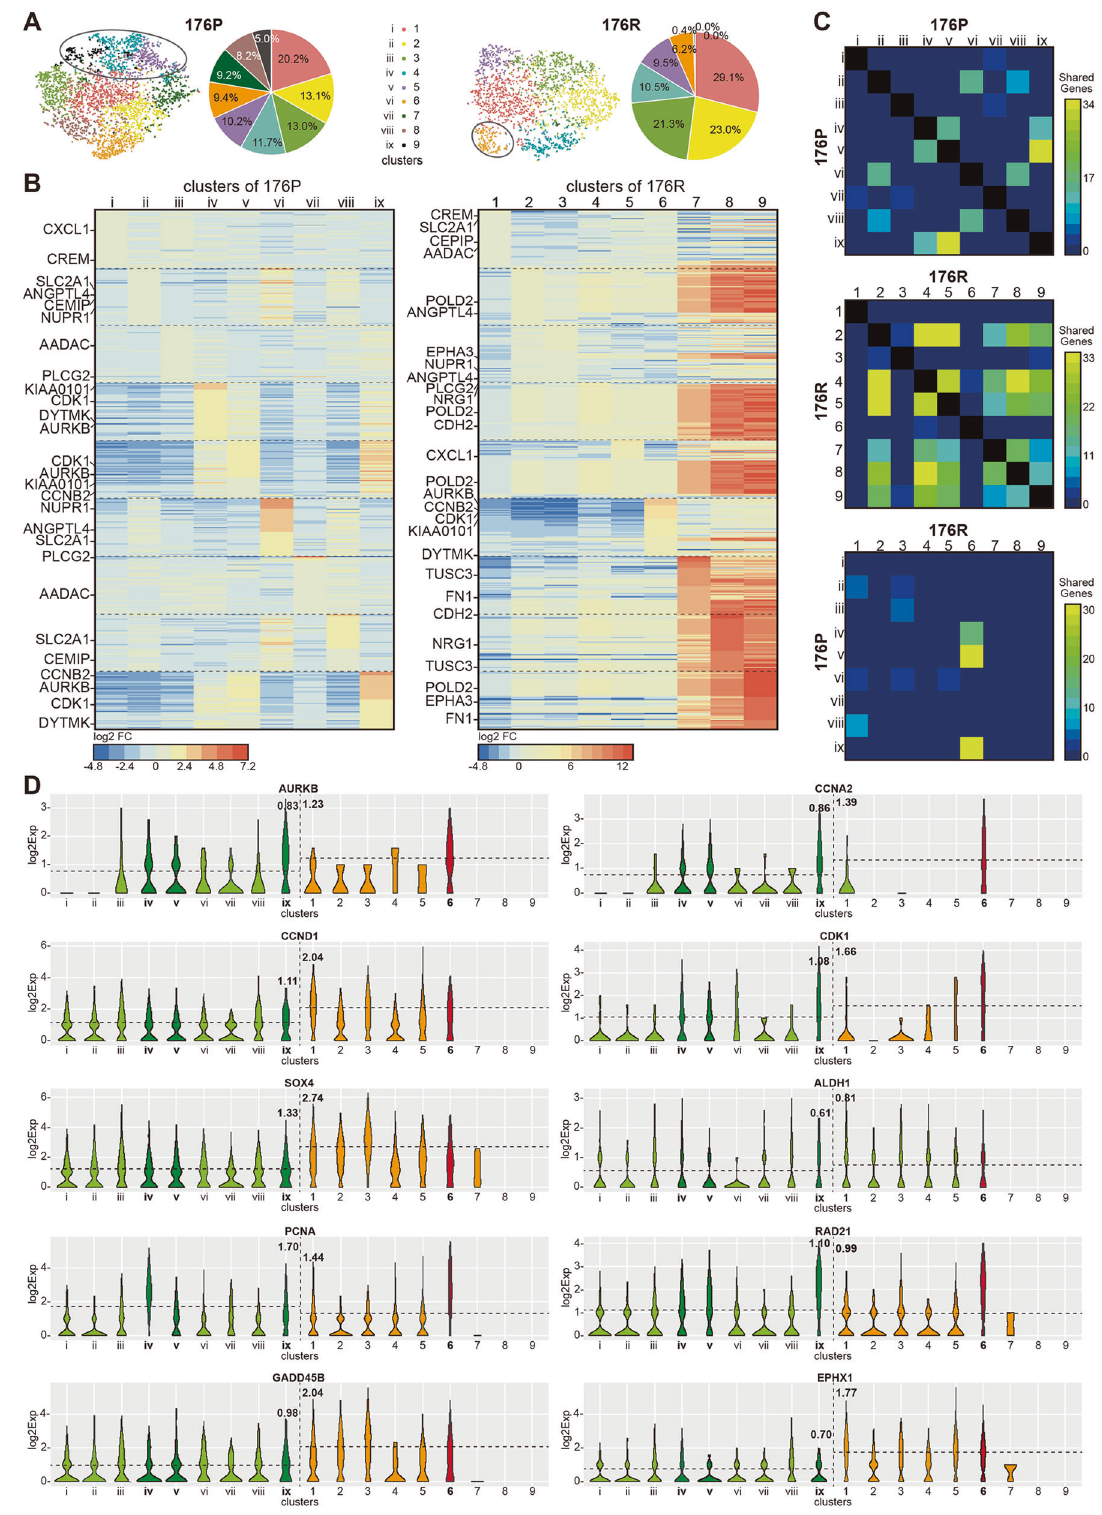
Fig. 4 Homology analysis revealed the evolved process from parental tissue to Trastuzumab resistant tissue. A 4311 cells of 176P and 2936 cells of 176R were divided into nine clusters by k-means algorithm, respectively. B Heatmaps showed the top 50 upregulated genes in each cluster compared to other eight clusters of 176P and 176R tissues. C Shared genes between clusters in the same samples or between clusters in different samples. D Some differentially expressed shared genes in different clusters of 176P and 176R tissues. Cluster 6 and cluster ix, v, iv were highlighted. Dashed lines represented log2 average expression of cells in both